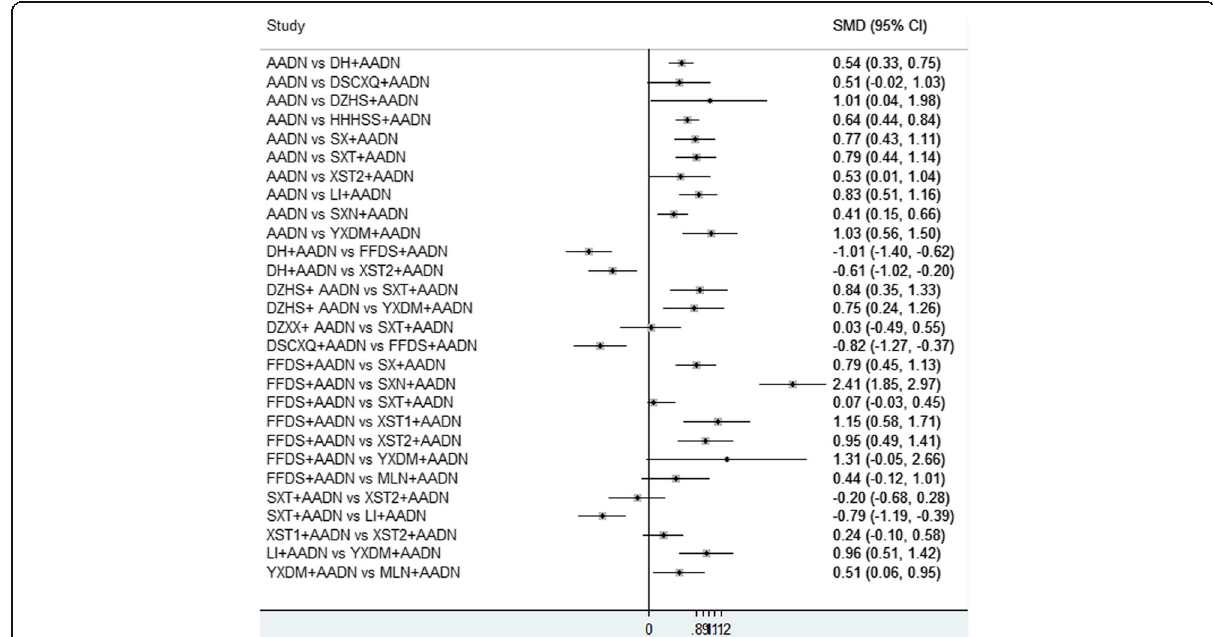
Fig. 4 Forest graph of Meta-analysis on the neurological impairment